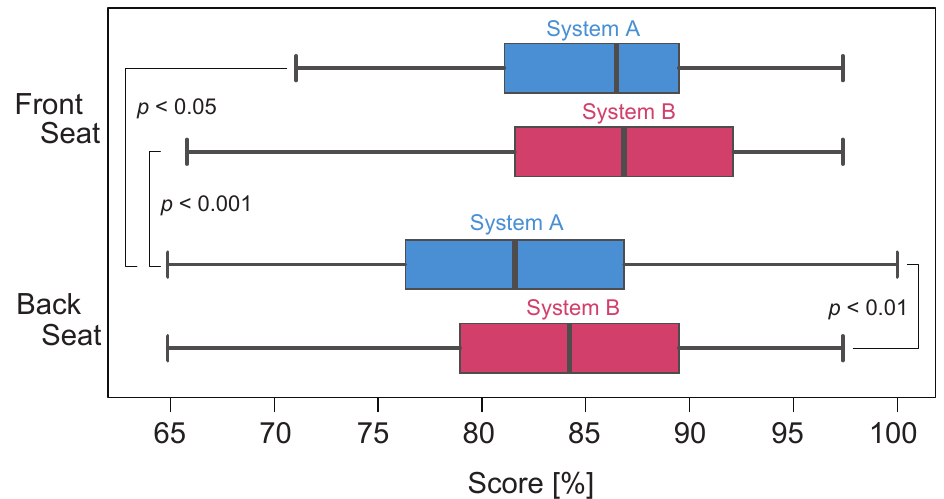
Figure 5. Box-and-whisker plots of sub groups divided according to sound amplification systems and seat locations. The centre line of the box is the median, the ends of the box are the quartiles, and the ends of the whiskers extend to 1.5 times the inter quartile range, in Seat vs. System